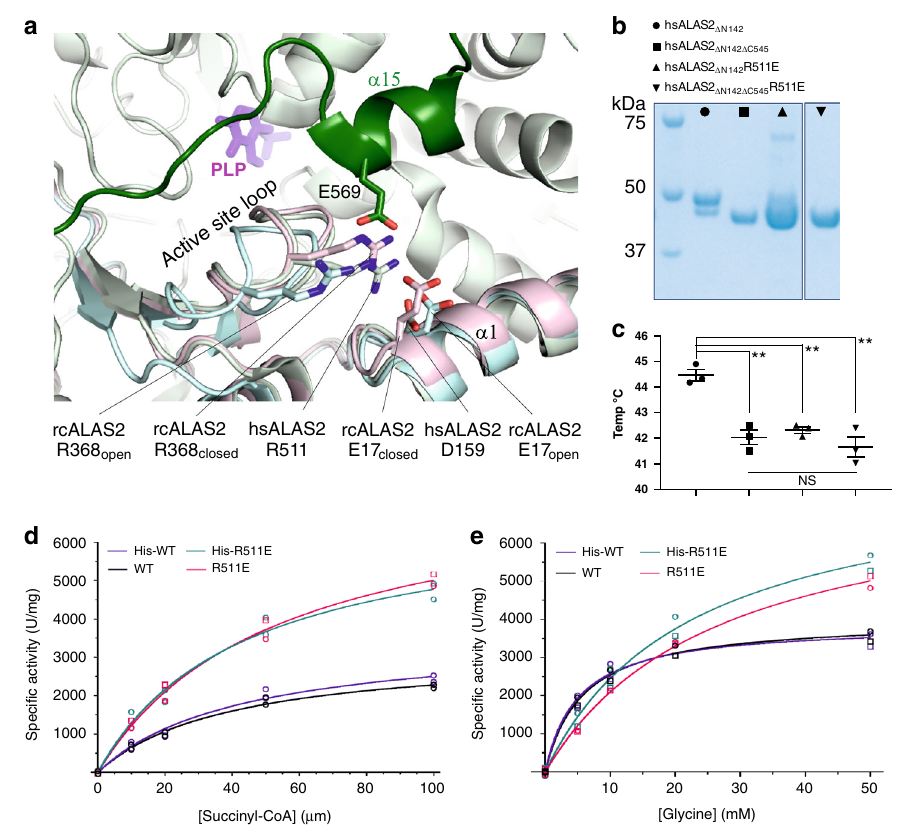
Fig. 3 Role of C-terminal extension in structural and functional integrity. a View of the hsALAS2 active site loop conformation within one monomer (catalytic domain light green, Ct-extension dark green). The active site loop from the open and closed forms of rcALAS (PDB 2BWN) are overlayed onto hsALAS2. b SDS-PAGE of the puri fi ed samples from hsALAS2 Δ N142 WT (square) and R511E variant (up triangle), as well as hsALAS2 Δ N142 Δ C545 WT (circle) and R511E variant (down triangle). c Midpoint melting temperatures, determined by differential scanning fl uorimetry, of the four samples in panel b . Error bars represent mean values ±SEM from n = 3 technical replicates. ** p -values determined by two sample t -test; p = 0.0026, 0.0011, and 0.0002 from left to right. d , e Progression curves for recombinant hsALAS2 Δ N142 WT and R511E variant, for both His-tagged and untagged proteins. Speci fi c activity is equivalent to the initial velocity normalized to protein in each assay. Succinyl-CoA and glycine titrations contained 50 mM glycine and 100 μ M succinyl- CoA, respectively. Each nonlinear regression line was fi tted to data from two biological replicates ( n = 2), with the data for each replicate (average of two technical replicates) plotted as distinct symbols (circle and square). Source data for Fig. 3b – e are provided as a Source Data fi le.